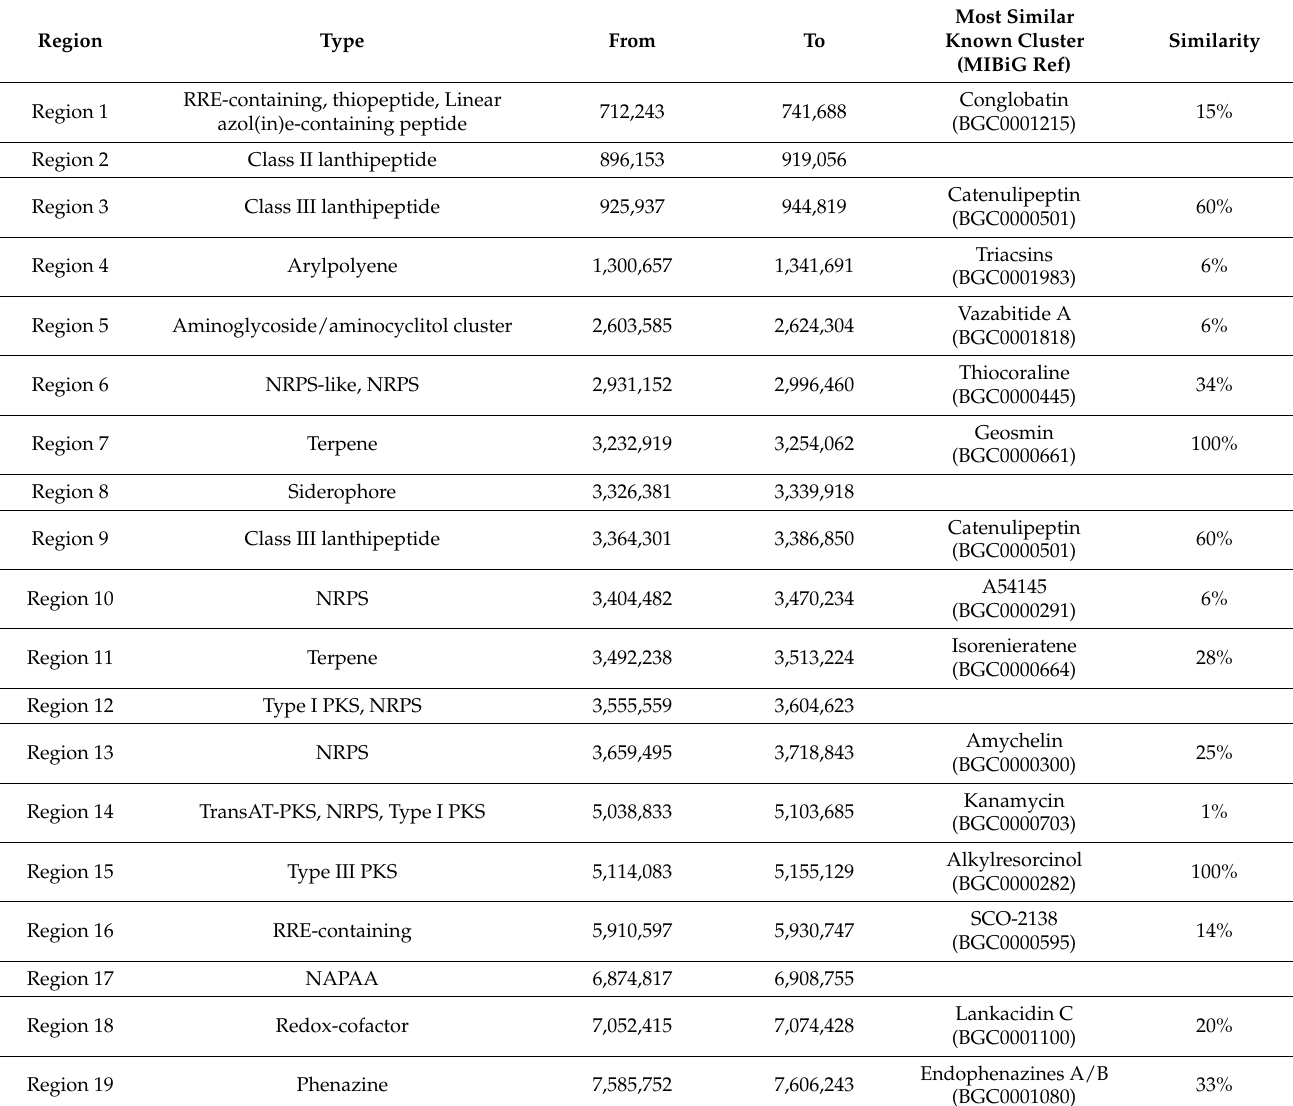
Table 1. Putative biosynthetic gene clusters identified by antiSMASH in the genome of Kribbella sp.